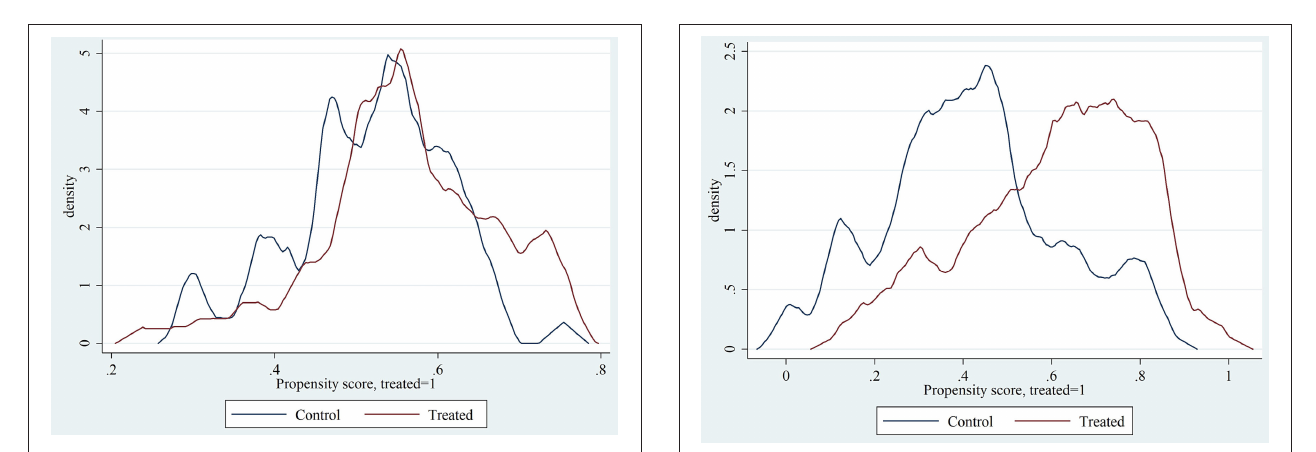
FIGURE 1 | Propensity score distribution by treatment status—Ucayali site. FIGURE 2 | Propensity score distribution by treatment status—Madre de Dios